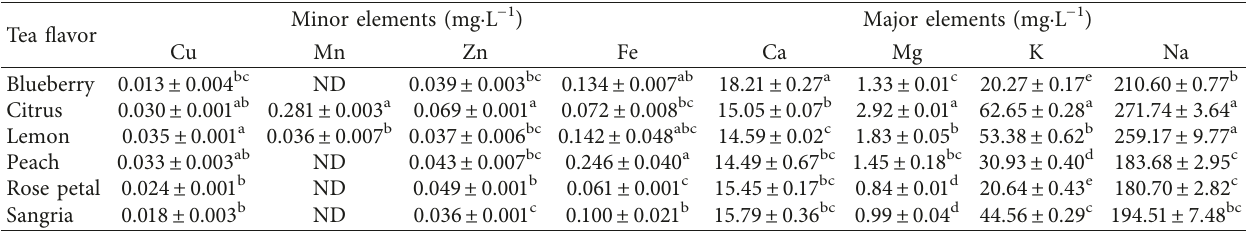
Values with different letters within same evaluation are significantly different ( p < 0 . 05, n � 3). ND � not